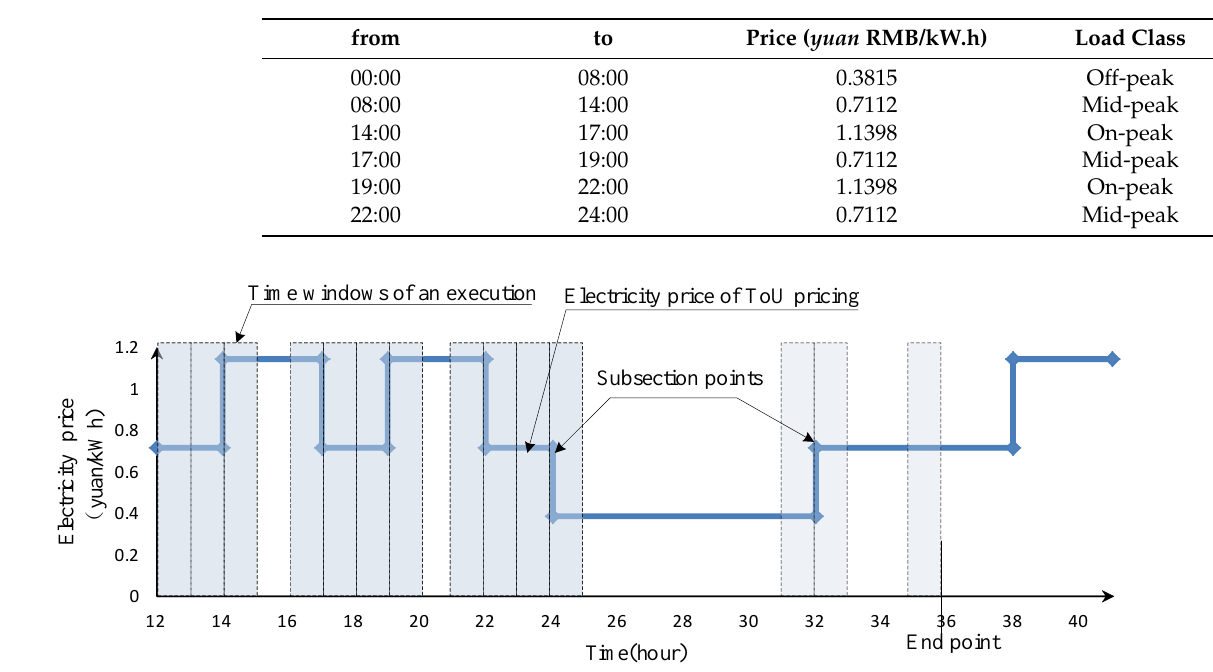
Table 2. ToU pricing in Guangdong, China.